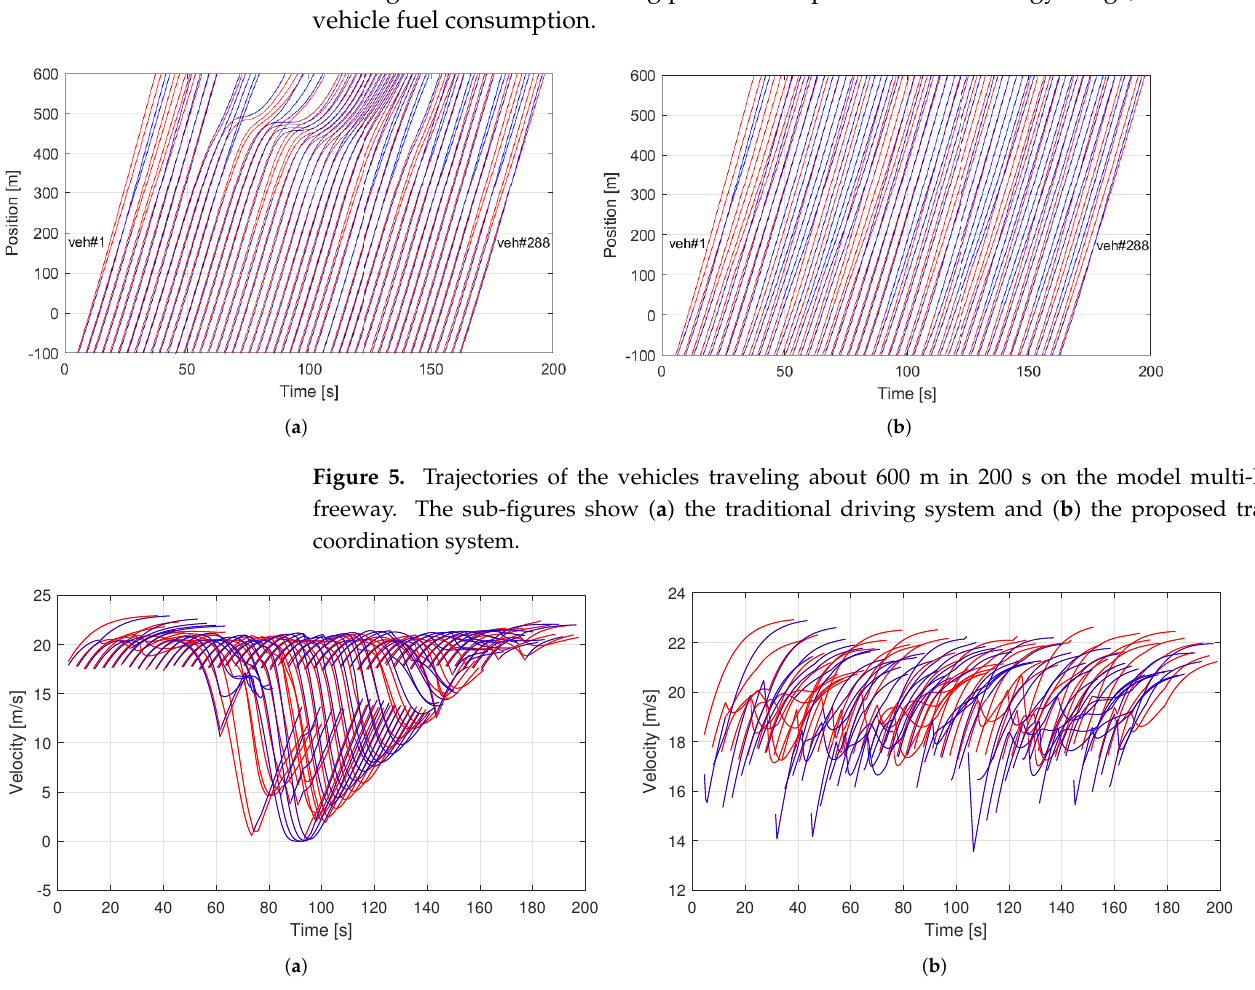
Figure 6. Velocity profiles of the vehicles showing speeding and slowing down characteristics for ( a ) the traditional driving system and ( b ) the proposed traffic coordination